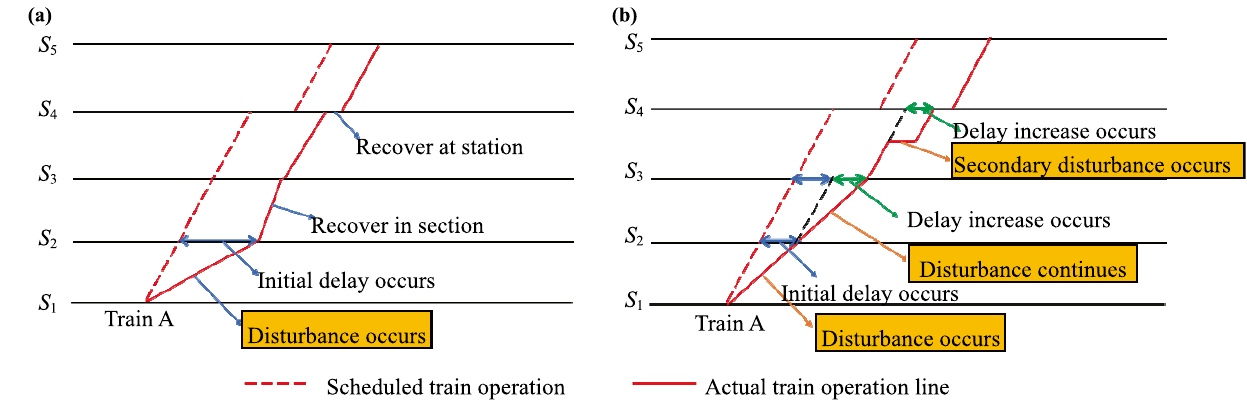
Fig. 1 The delay increase or recovery process after the initial delay of the train: a the process of train delay recovery; b the process of train delay